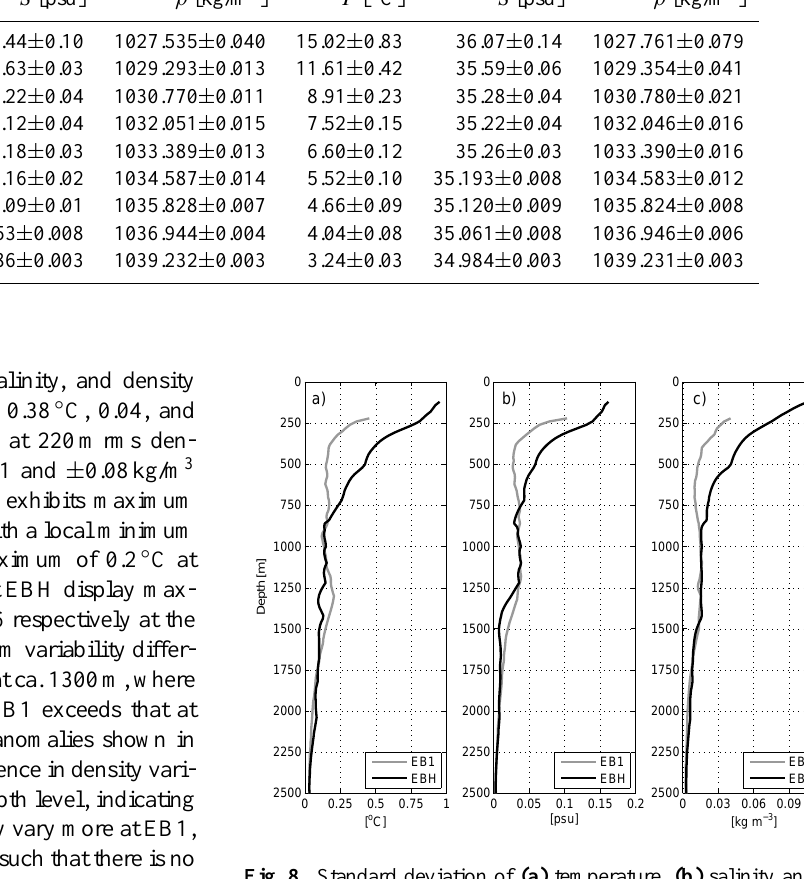
Fig. 8. Standard deviation of (a) temperature, (b) salinity and (c) in-situ density at each depth level between the surface and 2500m for EB1 (gray lines) and EBH (black lines). The standard deviation is computed for the period when both EB1 and EBH have full-depth measurements (13 April 2005 to 14 October